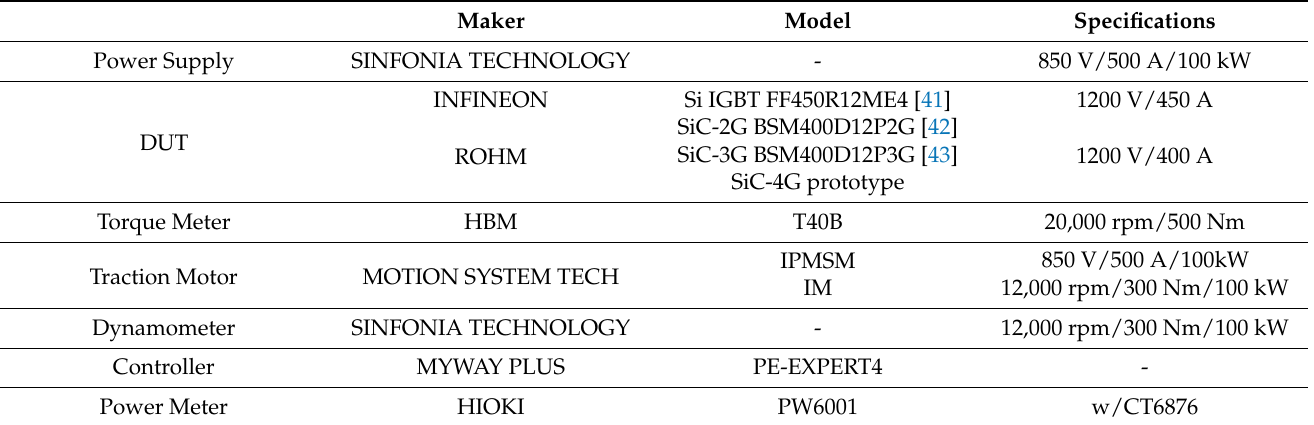
Table 3. Parameters of driven DUT